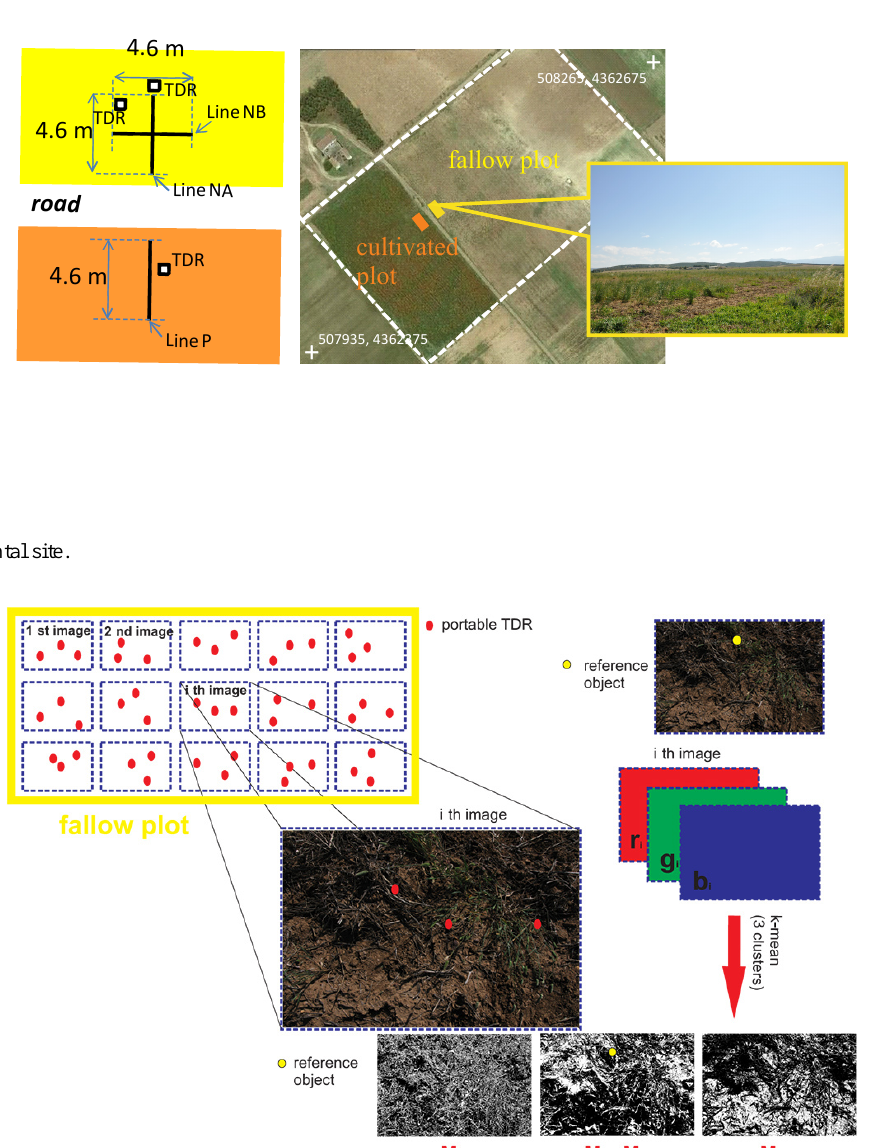
Fig. 2. Local measurements of vegetation density and soil moisture by combined VIA and repeated TDR